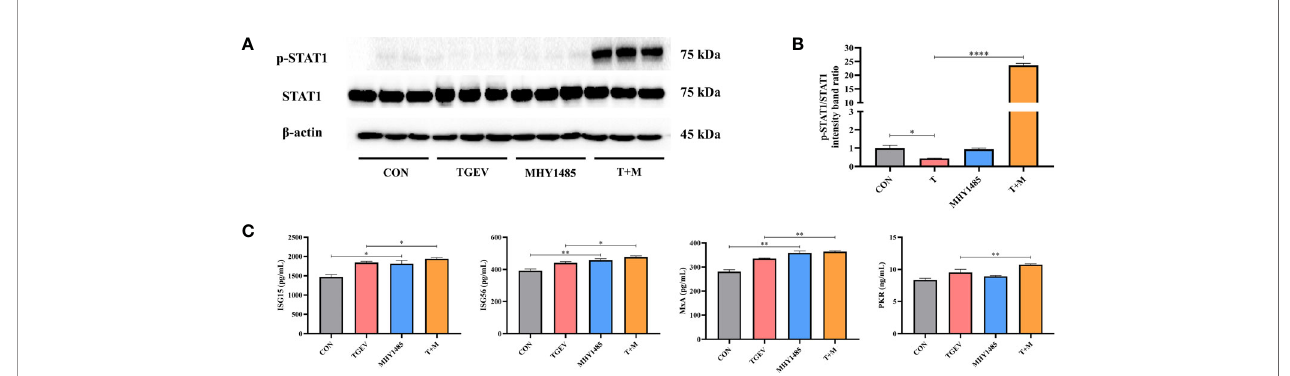
FIGURE 5 | The inhibition of STAT1 and ISGs induced by TGEV infection was alleviated by MHY1485 pretreatment. (A) Both p-STAT1 and STAT1 levels were detected by western blot. (B) Quantitation of bands to demonstrate the protein level of p-STAT1/STAT1. Data express the means ± SEMs (n = 3). (C) The expressions of ISGs (ISG15, ISG56, MxA and PKR) were detected by ELISA. Data express the means ± SEMs (n = 3). The symbol * indicates statistically signi fi cant differences ( P < 0.05), ** P < 0.01 and **** P